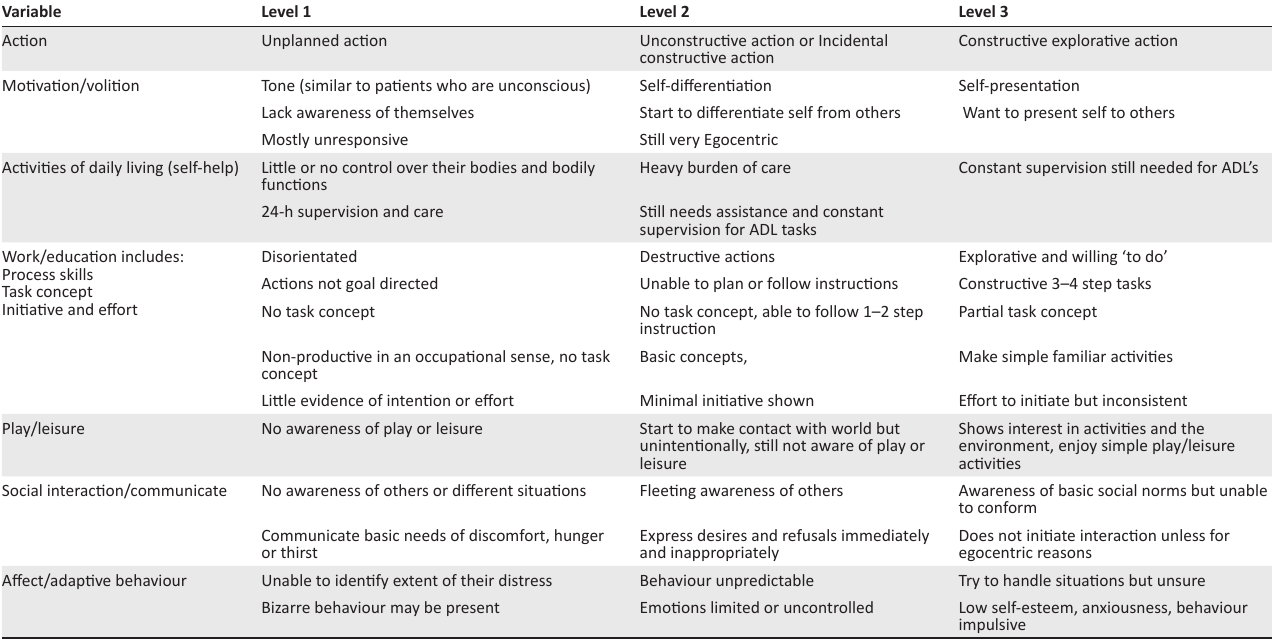
TABLE 1: Summary of first three levels of creative ability.